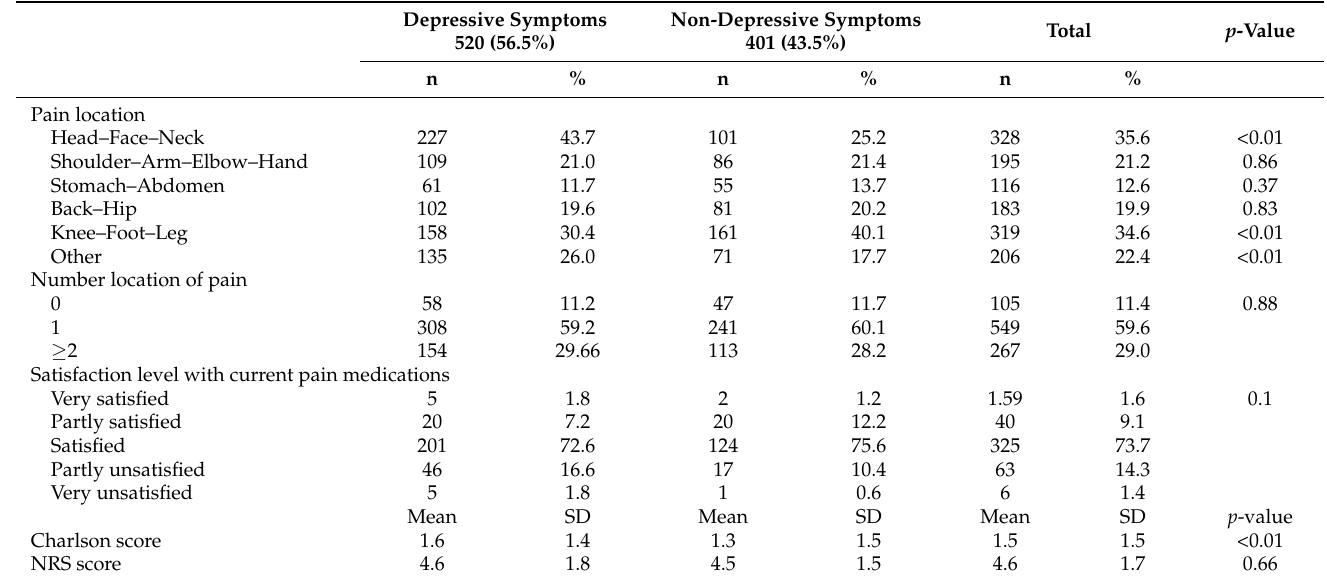
Table 2. Pain characteristics in participants (n =